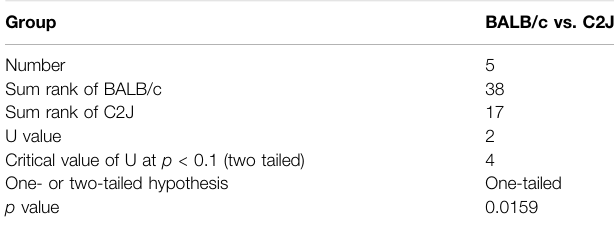
TABLE 3 | Statistical analysis of difference in initial permeability rates between BALB/c and C2J mice post 40 kDa FITC-dextran injection by Mann – Whitney U test.